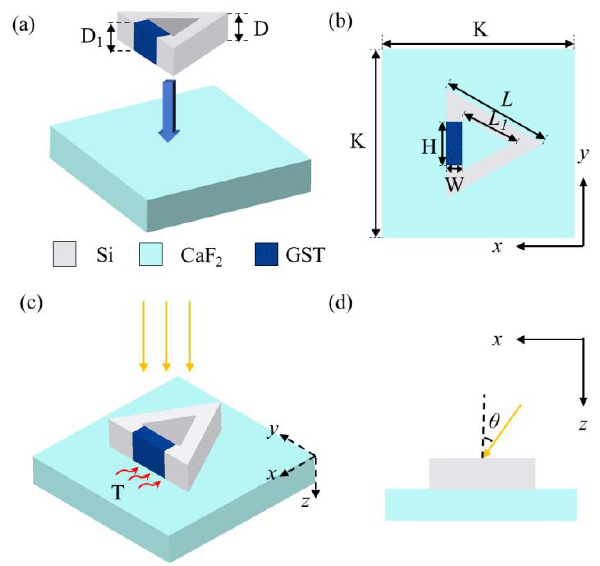
Figure 1. ( a ) Three-dimensional configuration of the unit cell; ( b ) top view of the unit cell; ( c ) configuration of the enlightened unit cell baked by an external heat source; yellow arrows indicate the linearly polarized incident plane wave; ( d ) incidence angle of the linearly polarized incident plane